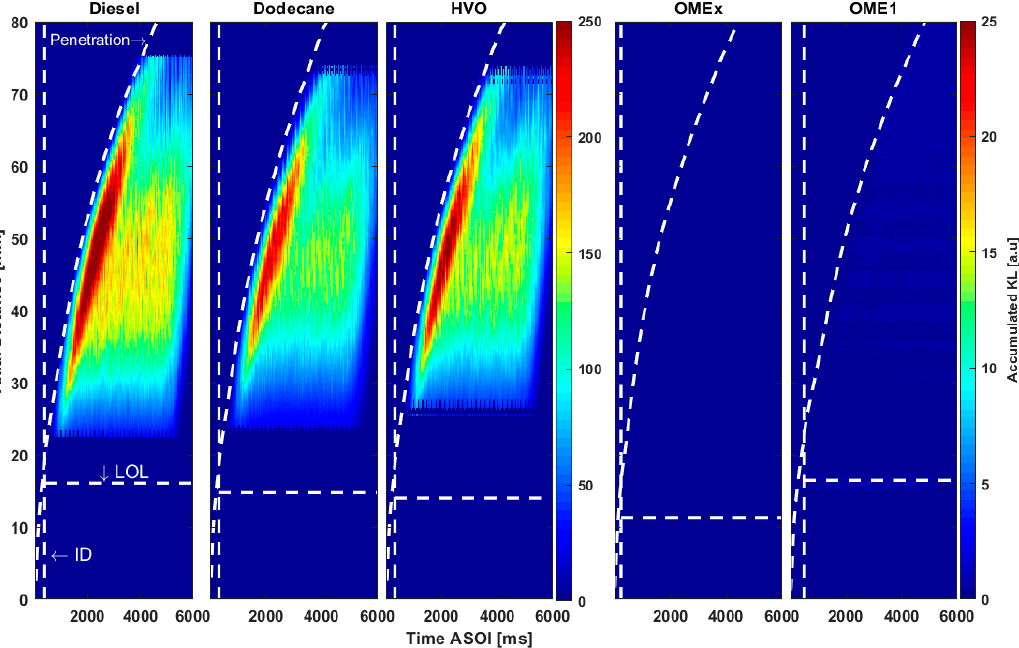
Figure 12. Accumulated KL map at the operating condition with the greatest tendency to soot formation (1000 K of temperature, 500 bar of injection pressure and 15% of O 2 ).